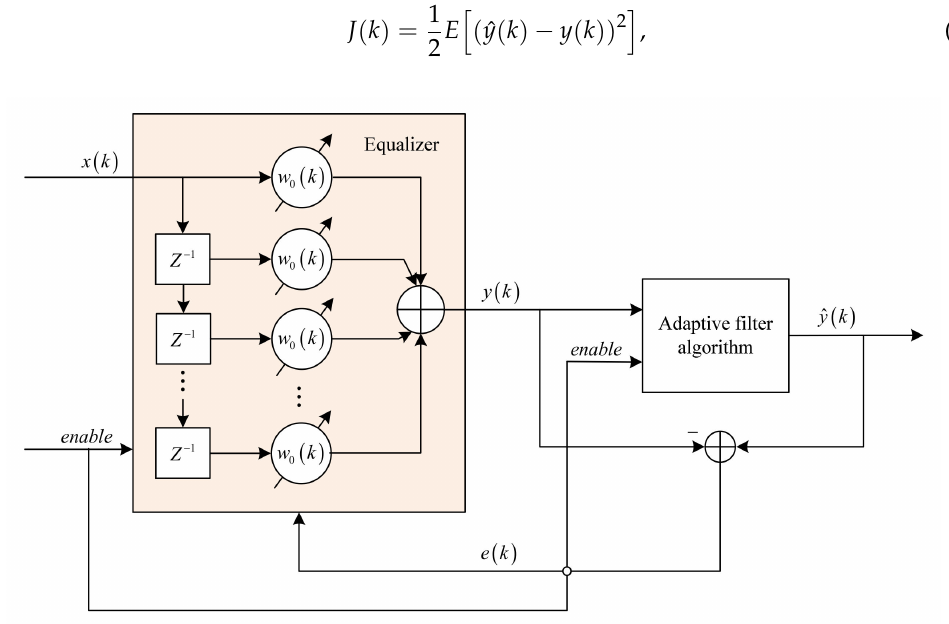
Figure 3. Structure diagram of the VM-DDLMS